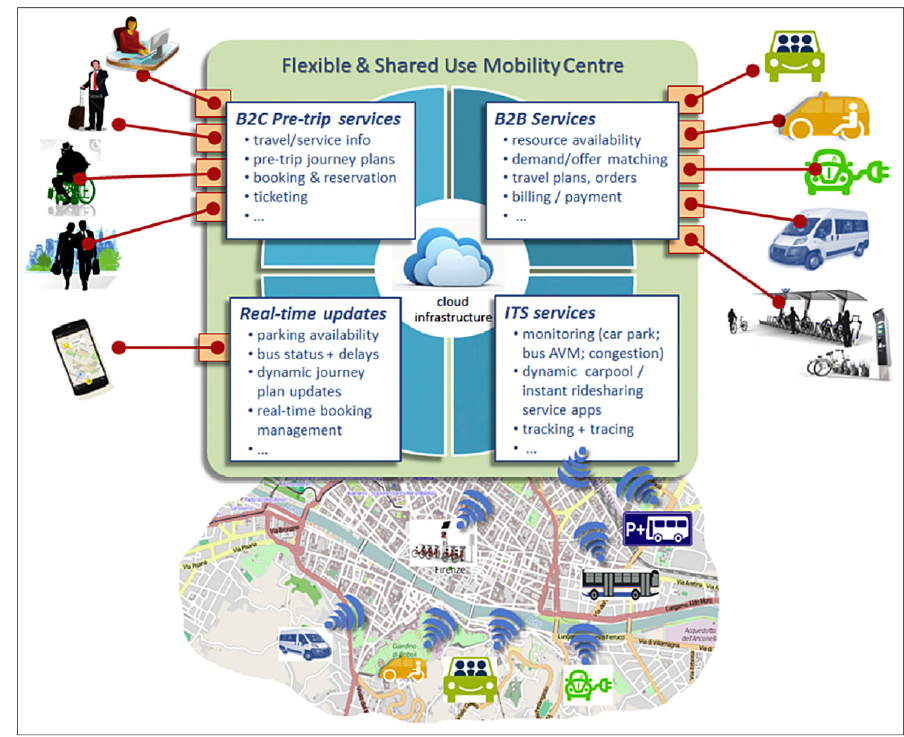
Figure A2. Conceptual architecture of the Flexible and Shared Use Mobility Centre. Reproduced from Ambrosino et al. [21] (p. 183).